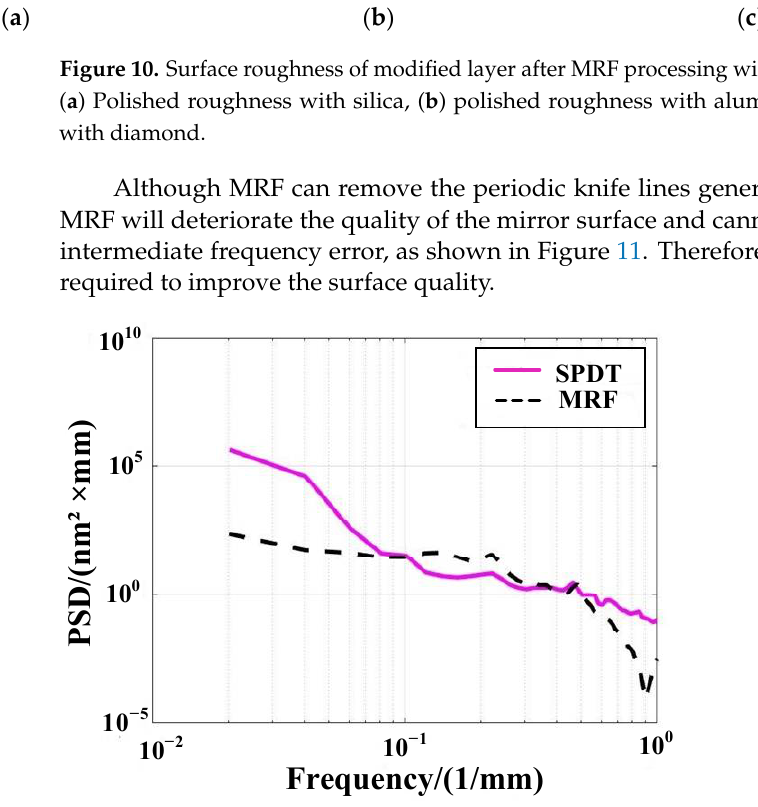
Figure 11. PSD Analysis of SPDT and MRF machining.